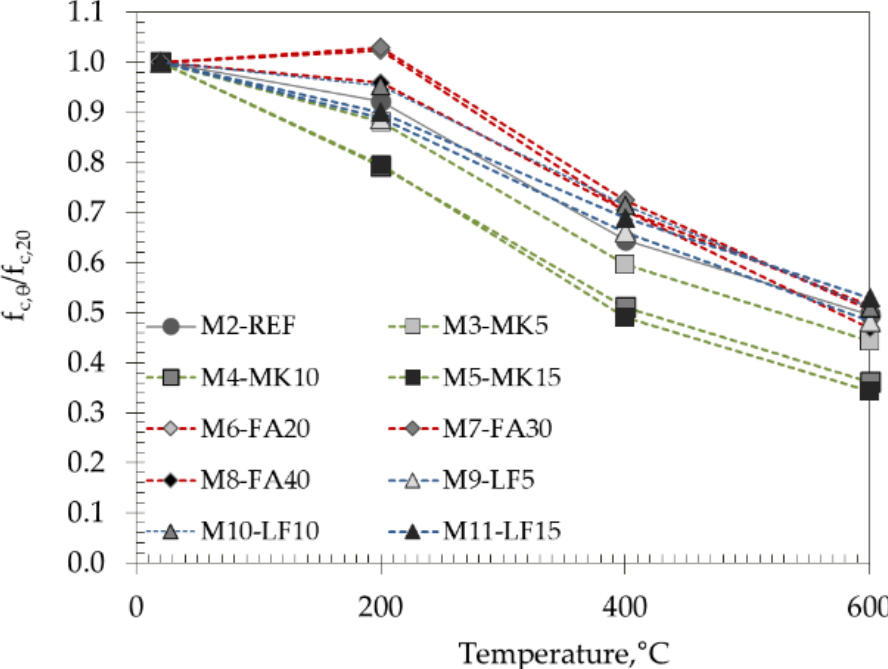
Figure 10. Normalized values of compressive strength vs. temperature.